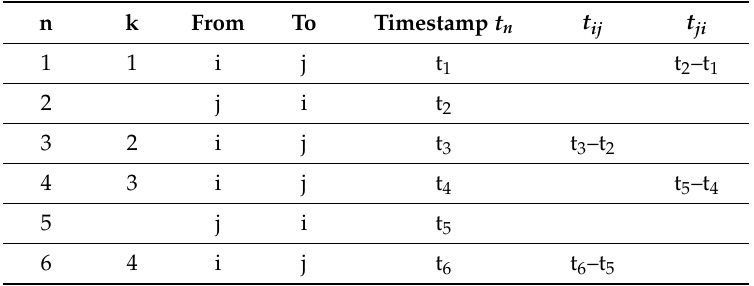
Table 6. Example of calculation of email response